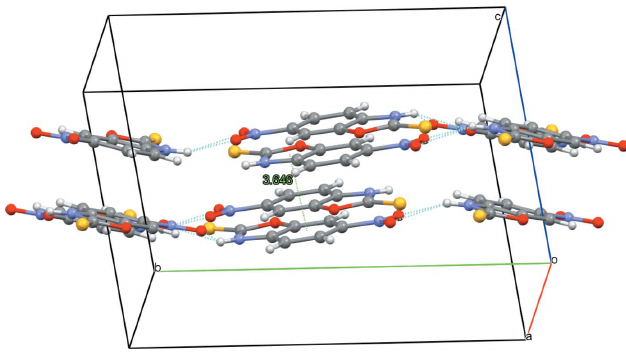
Figure 2 Projection of the title compound structure onto the (100) plane, showing molecules connected by hydrogen bonds (dashed blue lines).